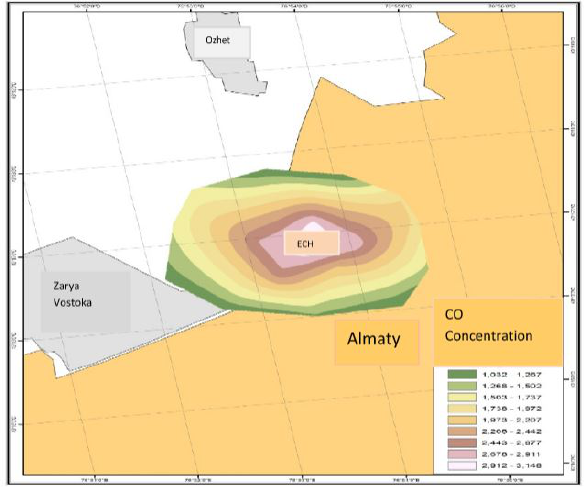
Figure 4: Testing the developed simulation model of the spread of harmful emissions into the environment, in the ArcGIS for Desktop (version 10.3) development